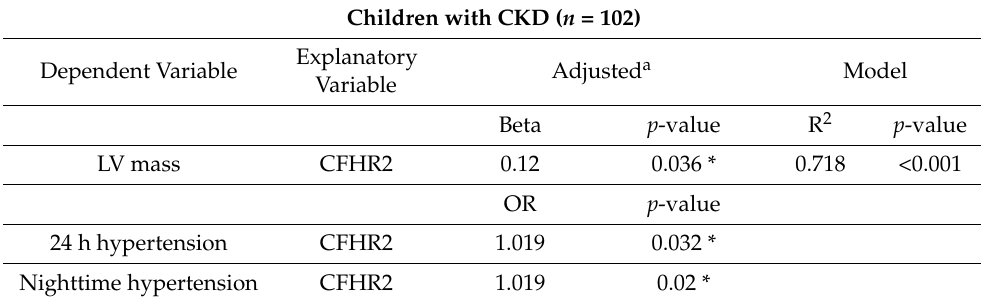
Table 4. Regression model of cardiovascular risks and CFH-related proteins in children with CKD.